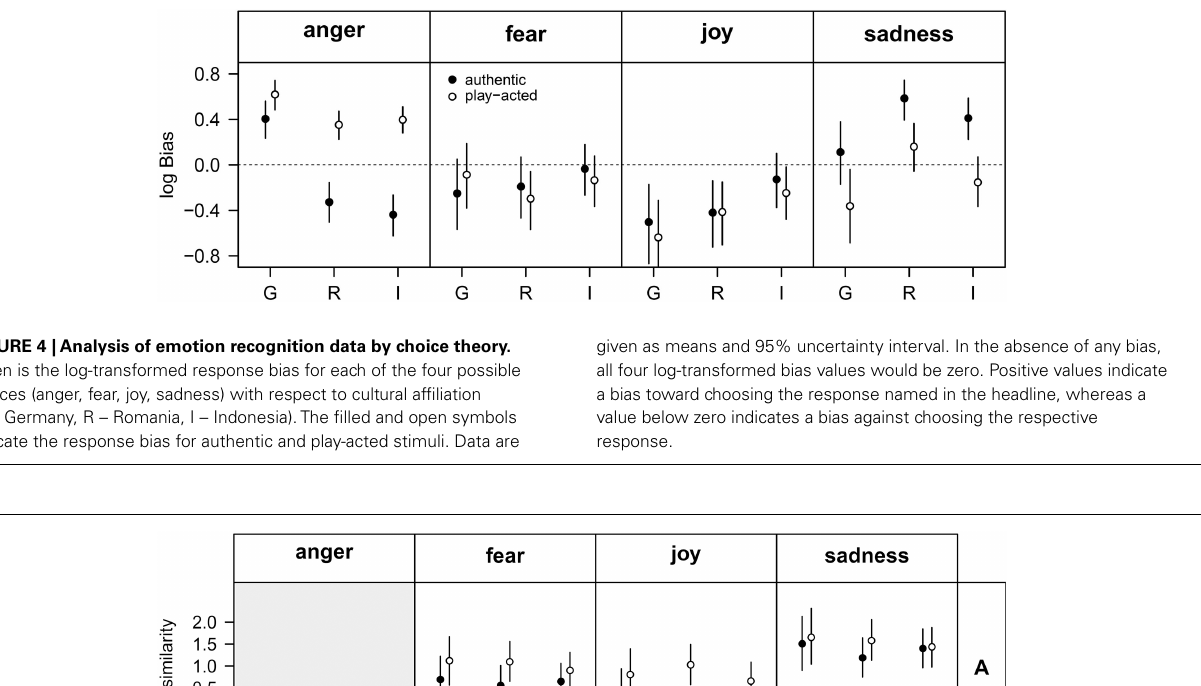
FIGURE 4 |Analysis of emotion recognition data by choice theory. Given is the log-transformed response bias for each of the four possible choices (anger, fear, joy, sadness) with respect to cultural affiliation (G – Germany, R – Romania, I – Indonesia).The filled and open symbols indicate the response bias for authentic and play-acted stimuli. Data are